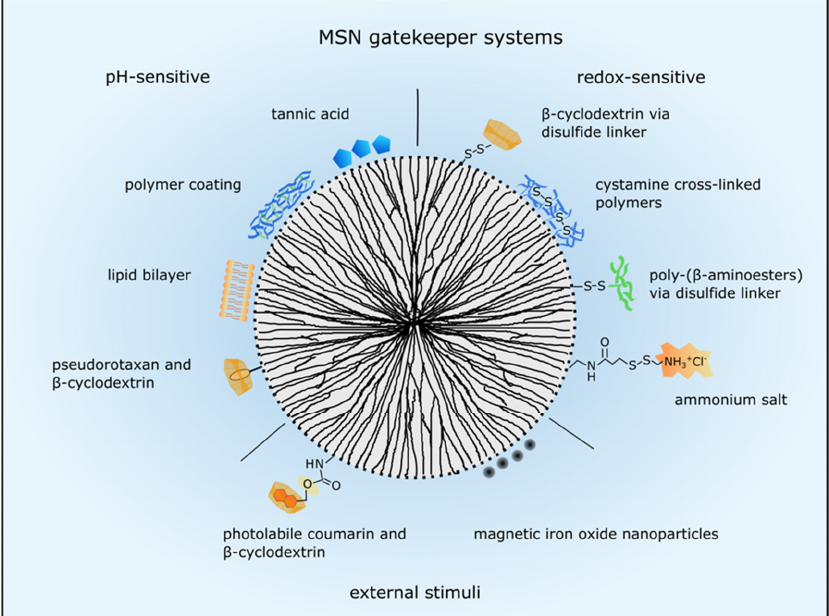
Figure 2. MSN gatekeeper systems to control drug release. Drug release can be regulated by internal stimuli such as pH decrease or reduction by glutathione or by external stimuli. PH-sensitive systems respond to acidic pH in the tumor microenvironment and in the endolysosomal system. Several and lipid coatings. Several capping structures are linked to the MSN via disulfide bonds which